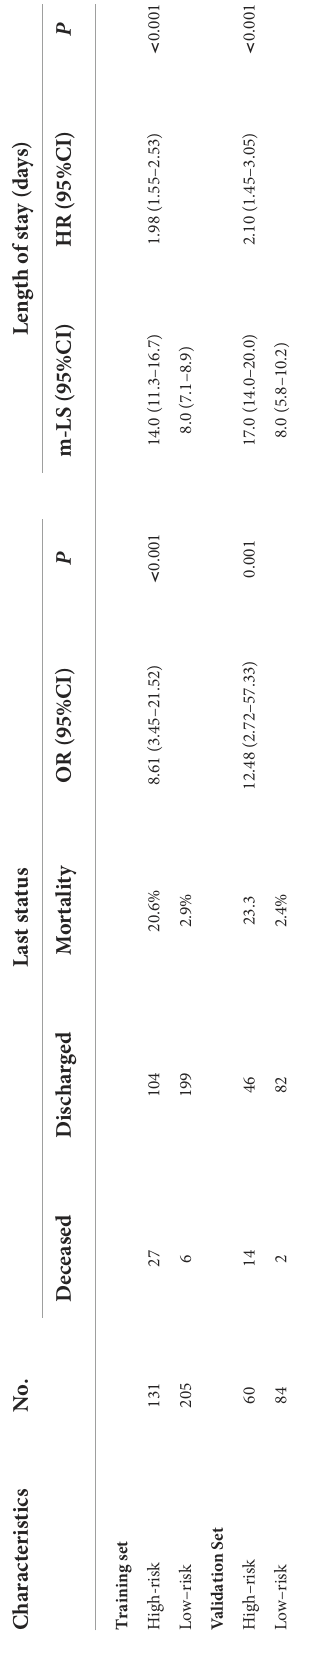
these predictive models (biomarkers) have some